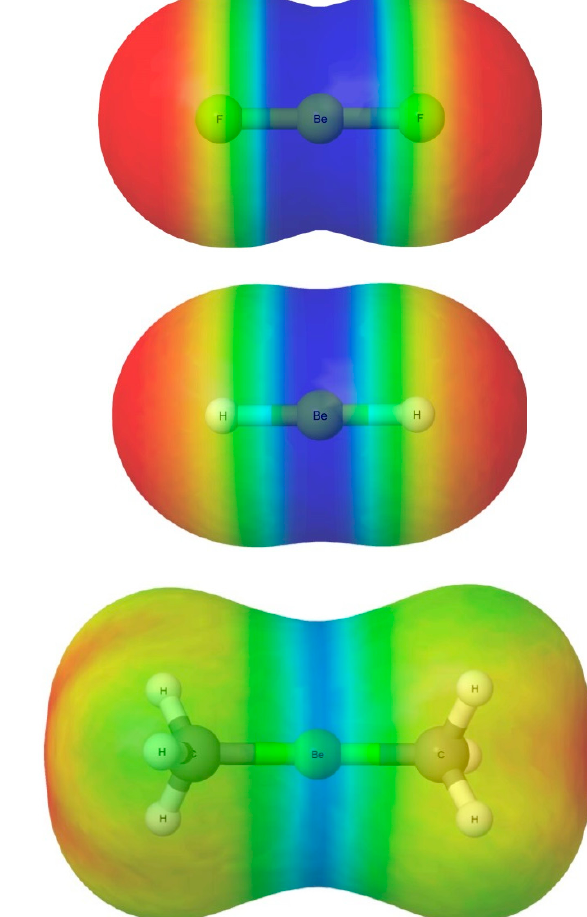
Figure 1. Molecular electrostatic potential surfaces of the linear non-polar molecules, BeF 2 , BeH 2 and Be(CH 3 ) 2 calculated at the 0.001 e/bohr 3 electron density isosurface at the CCSD/ aug-cc-pVTZ// CCSD(T)/aug-cc-pVTZ level of theory. The surface has been is made transparent to reveal the molecular model within. The most intense blue (and, therefore, the most electrophilic) belts centered on Be correspond to positive electrostatic potential energies of 337, 167 and 119 kJ · mol − 1 for BeF 2 , BeH 2 and Be(CH 3 ) 2 , respectively, and confirm expectations based on the inductive effects of CH 3 and F relative to H.